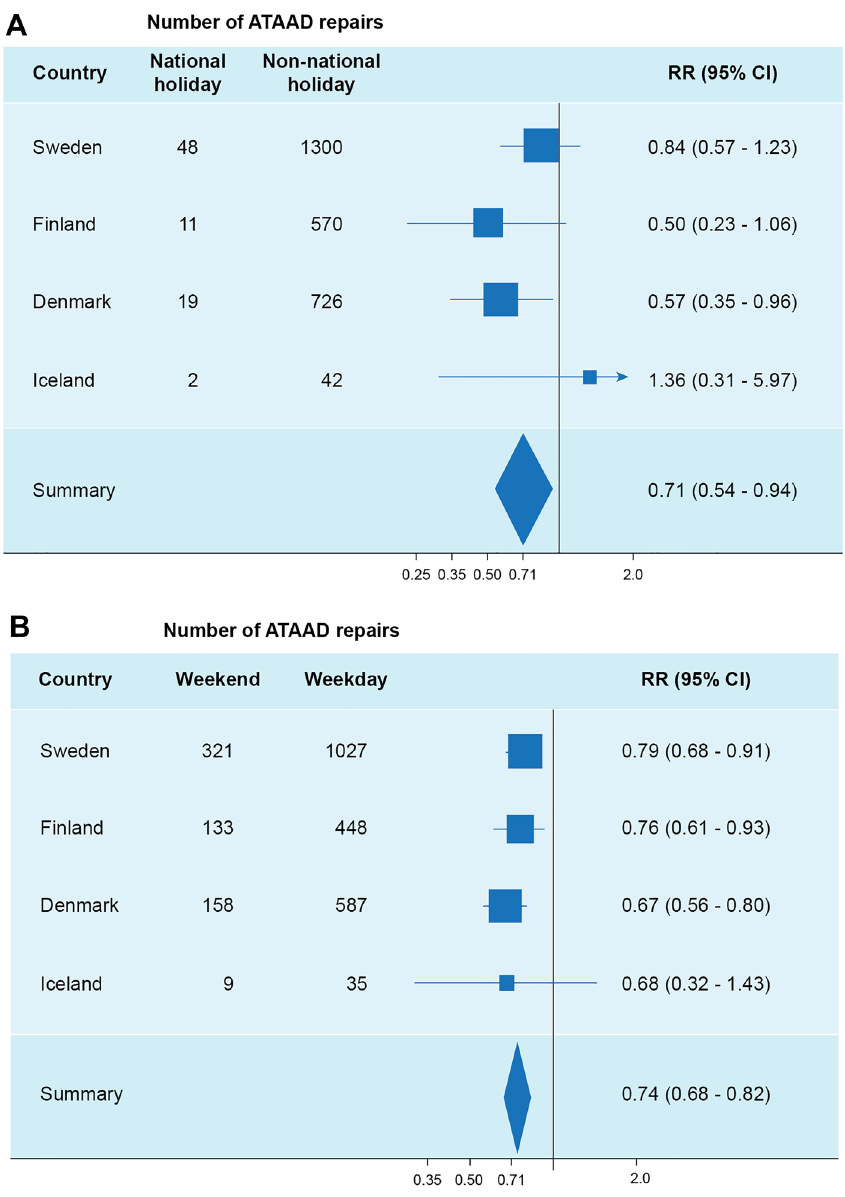
Figure 1. Forest plot illustrating the relative risk of surgery for ATAAD on national holidays (NH) ( a ) and weekends (w-end) and weekdays (w-days) ( b ) presented per country and